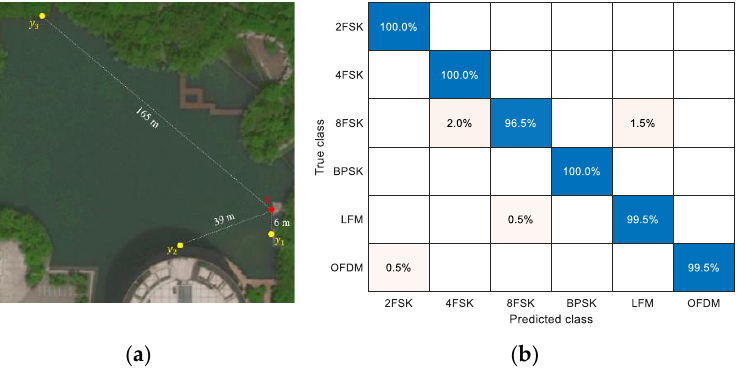
Figure 9. Actual underwater acoustic communication experiment. ( a ) Experimental equipment layout; ( b ) signal recognition confusion matrix and the average recognition accuracy of MHFNet is 99.3%.